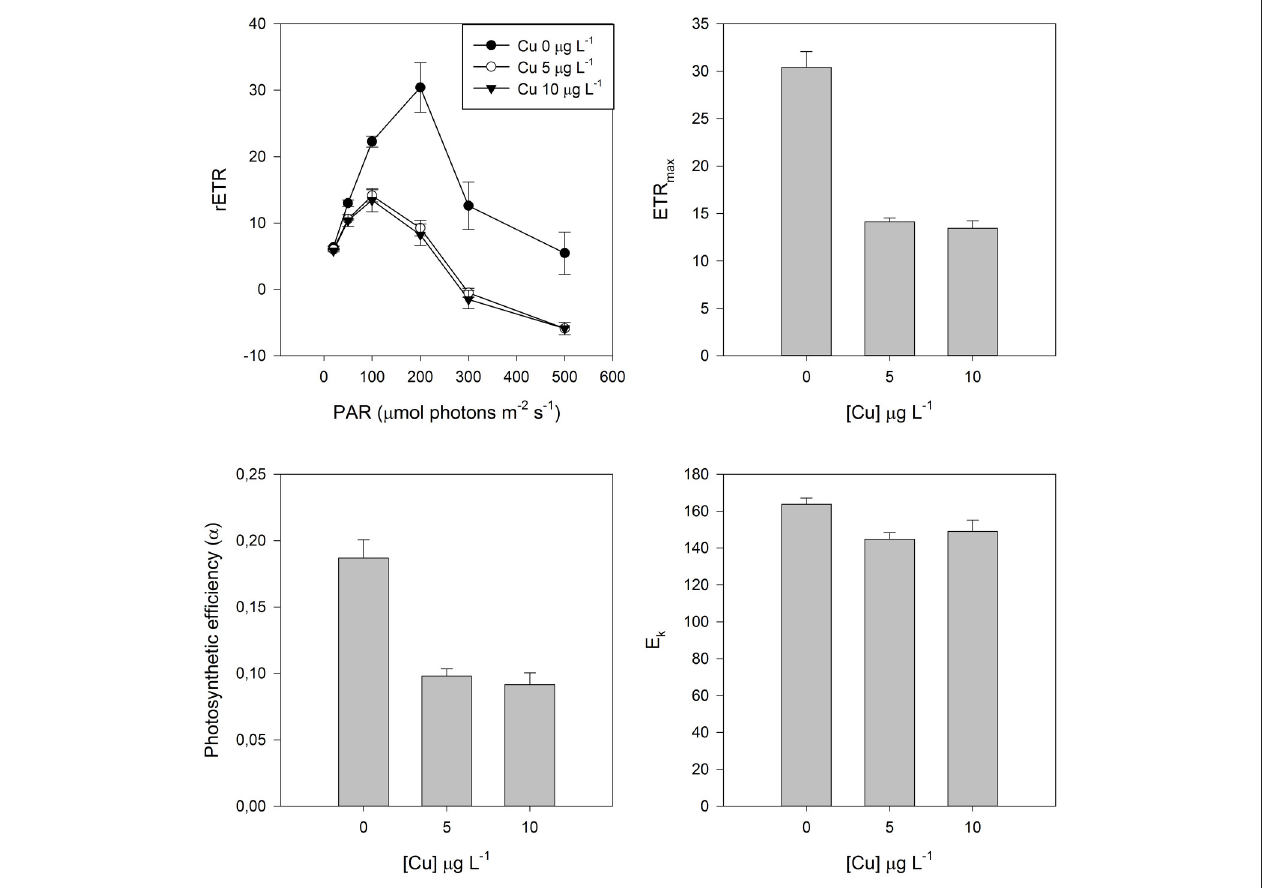
FIGURE 2 | Rapid Light Curves (RLC) and derived parameters in dark adapted leaves of Spartina patens exposed to increasing copper (Cu) doses. Data is presented as average ± standard deviation.